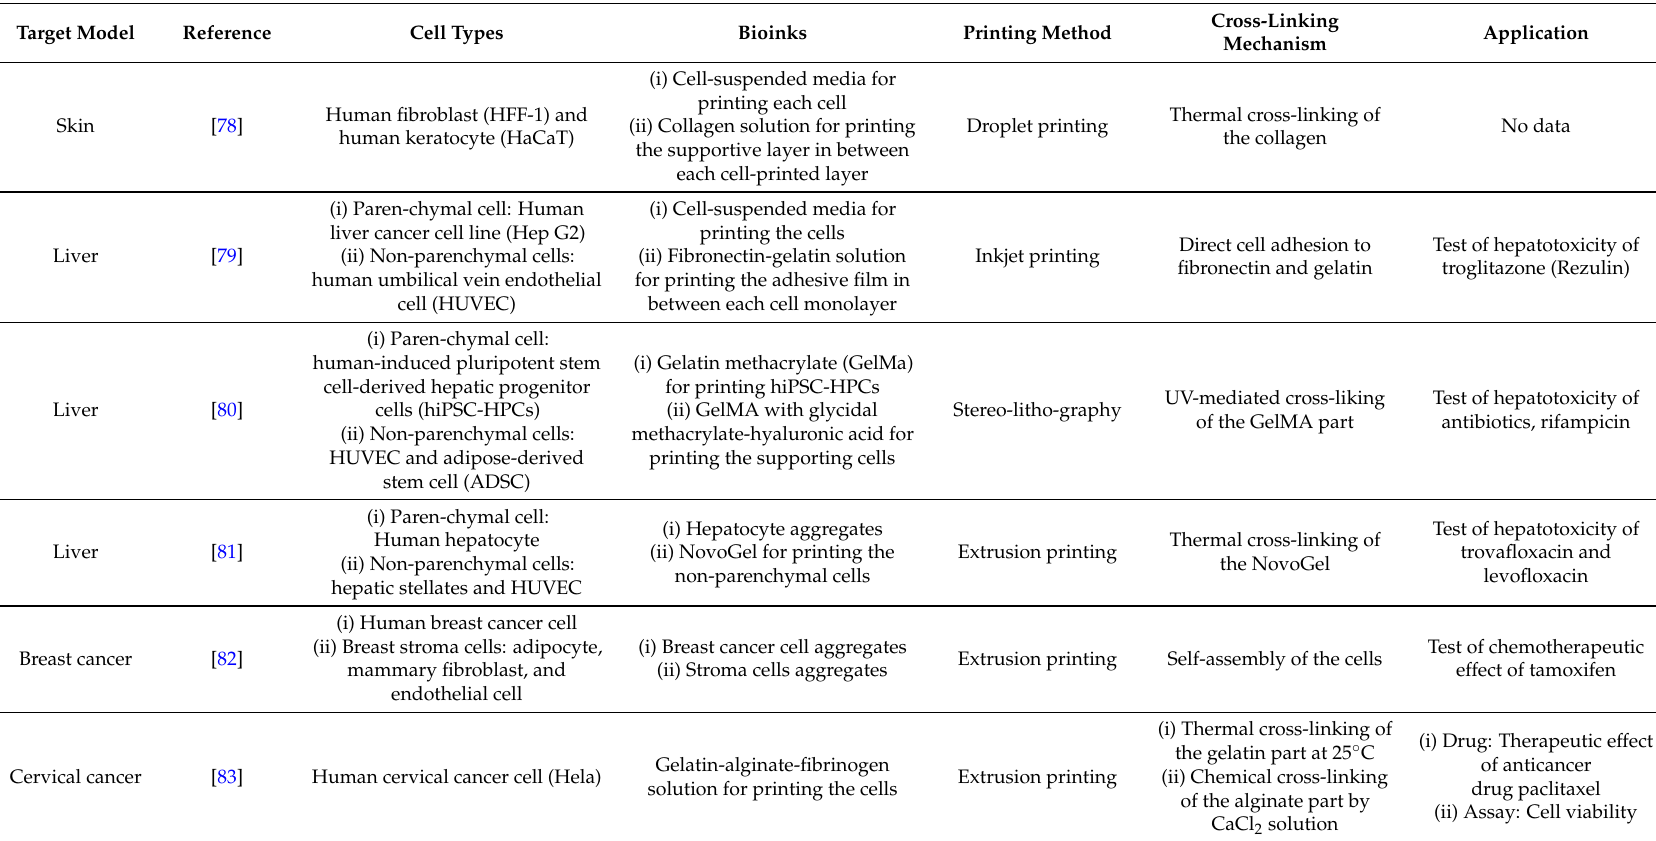
Table 1. Summary of 3D cell-printed organs-on-chips without